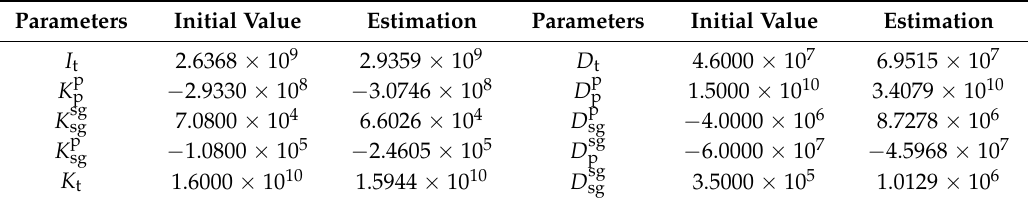
Table 3. Initial values and estimation results of the undetermined